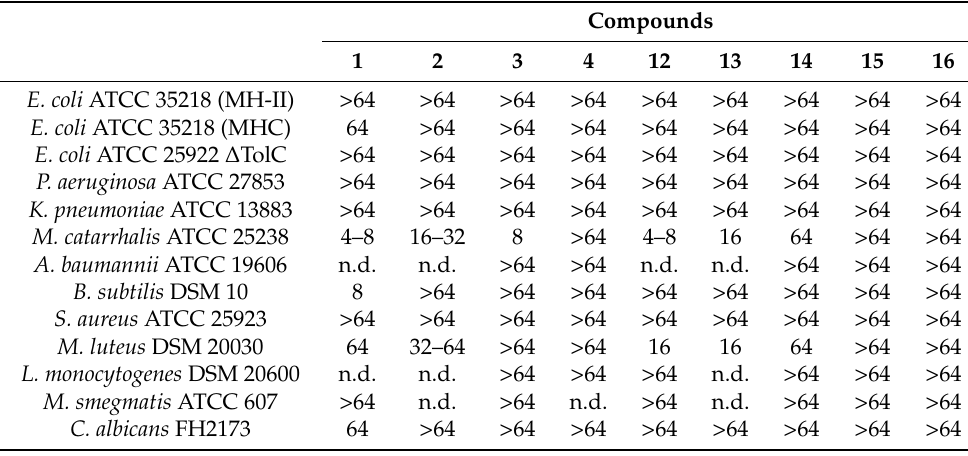
Table 3. MIC values ( µ g/mL) of compounds 1 – 4 and 12 – 16 . MHC = cation-adjusted Mueller–Hinton II medium supplemented with 3.7 g/L bicarbonate, n.d. = not